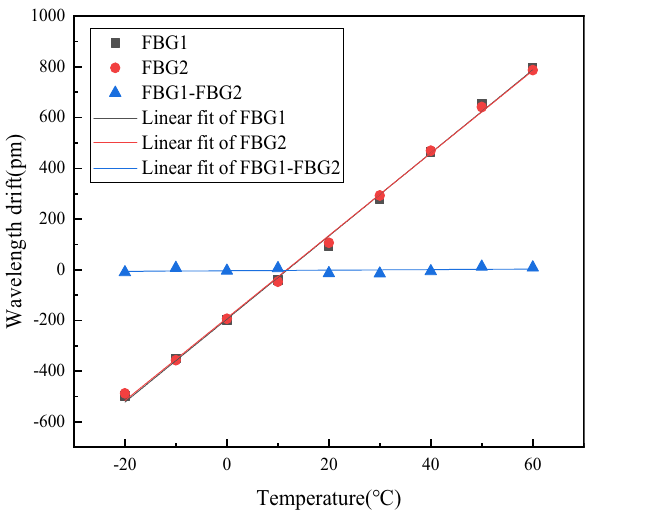
Figure 10. Effect of temperature on center